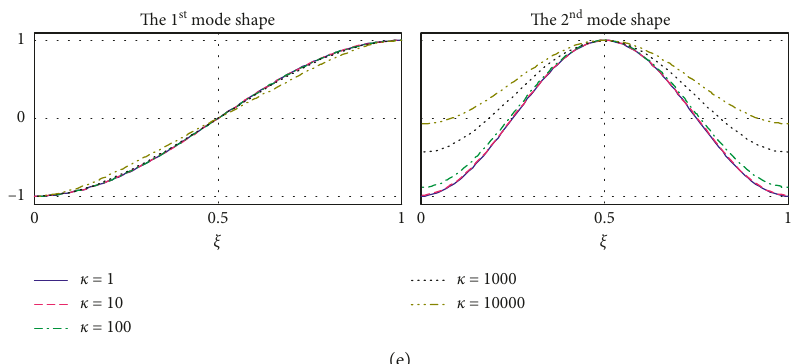
Figure 5: Variations of the first two mode shapes with κ for five degenerate cases: (a) Sl-Fi, (b) Fr-Sl, (c) Fr-Fi, (d) Fr-Sl, and (e) Sl-Sl.